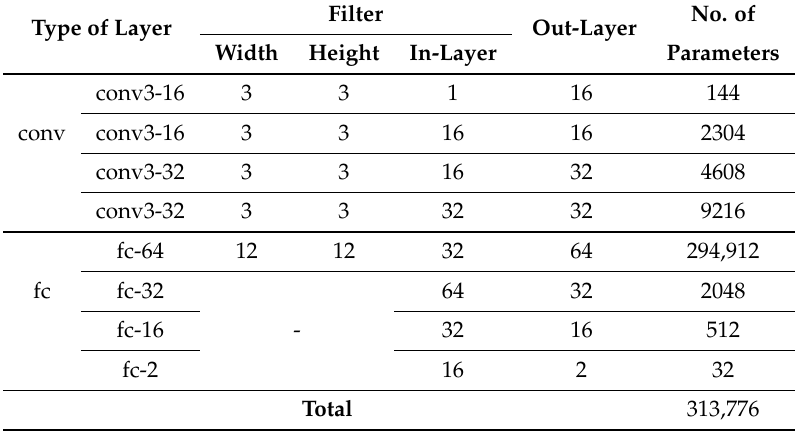
Table 1. The accuracies for valence and arousal with time